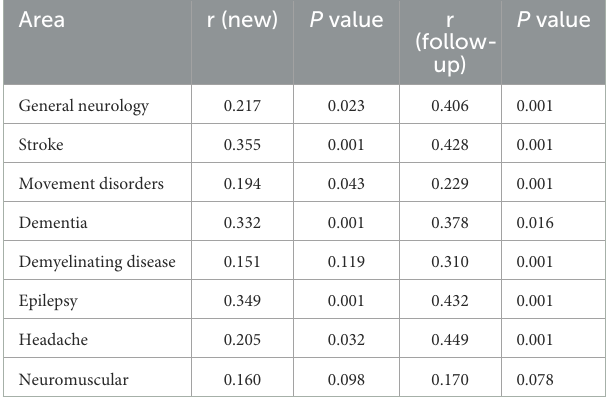
TABLE 4 Virtual clinic continuation by basic characteristics of participants.